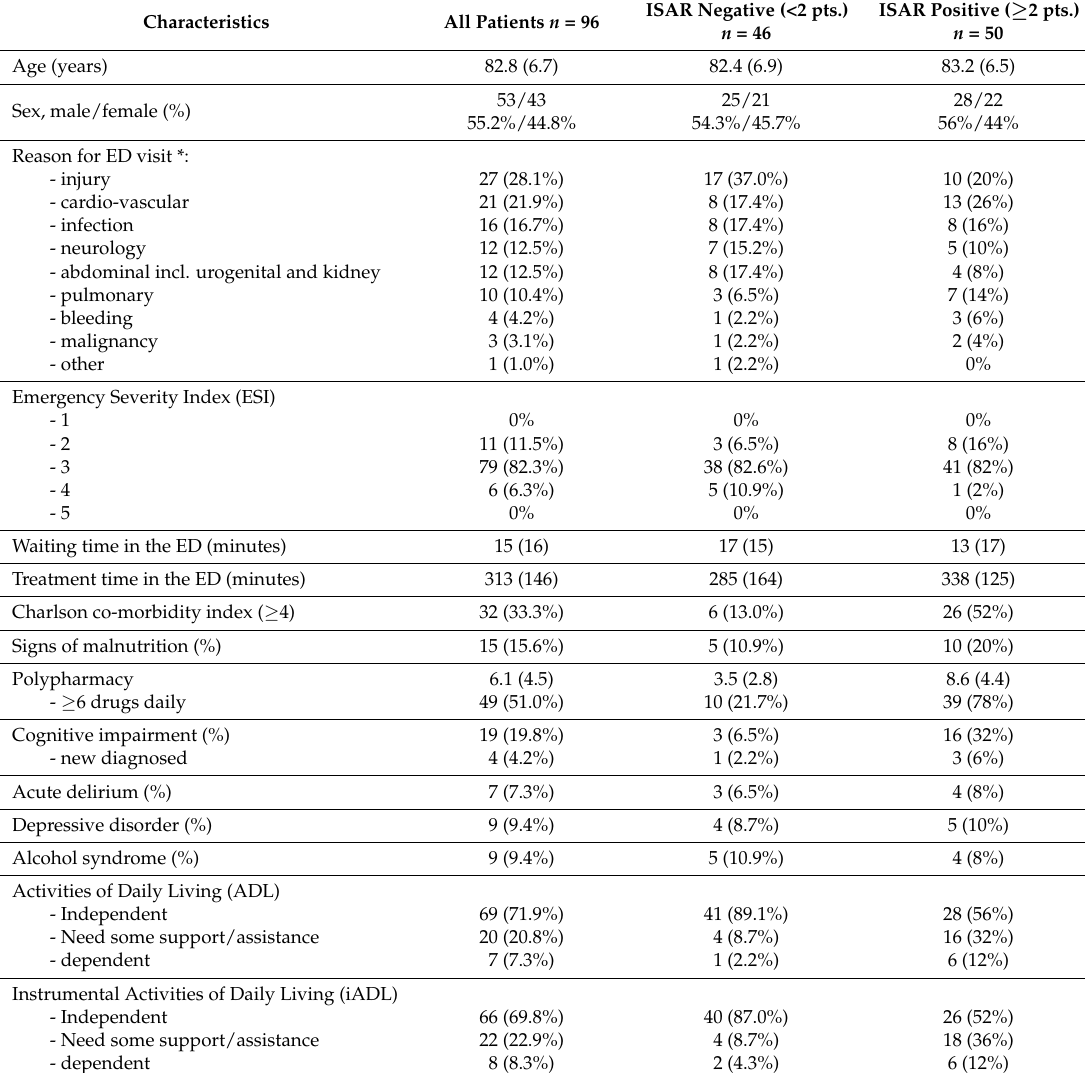
Table 1. Patients’